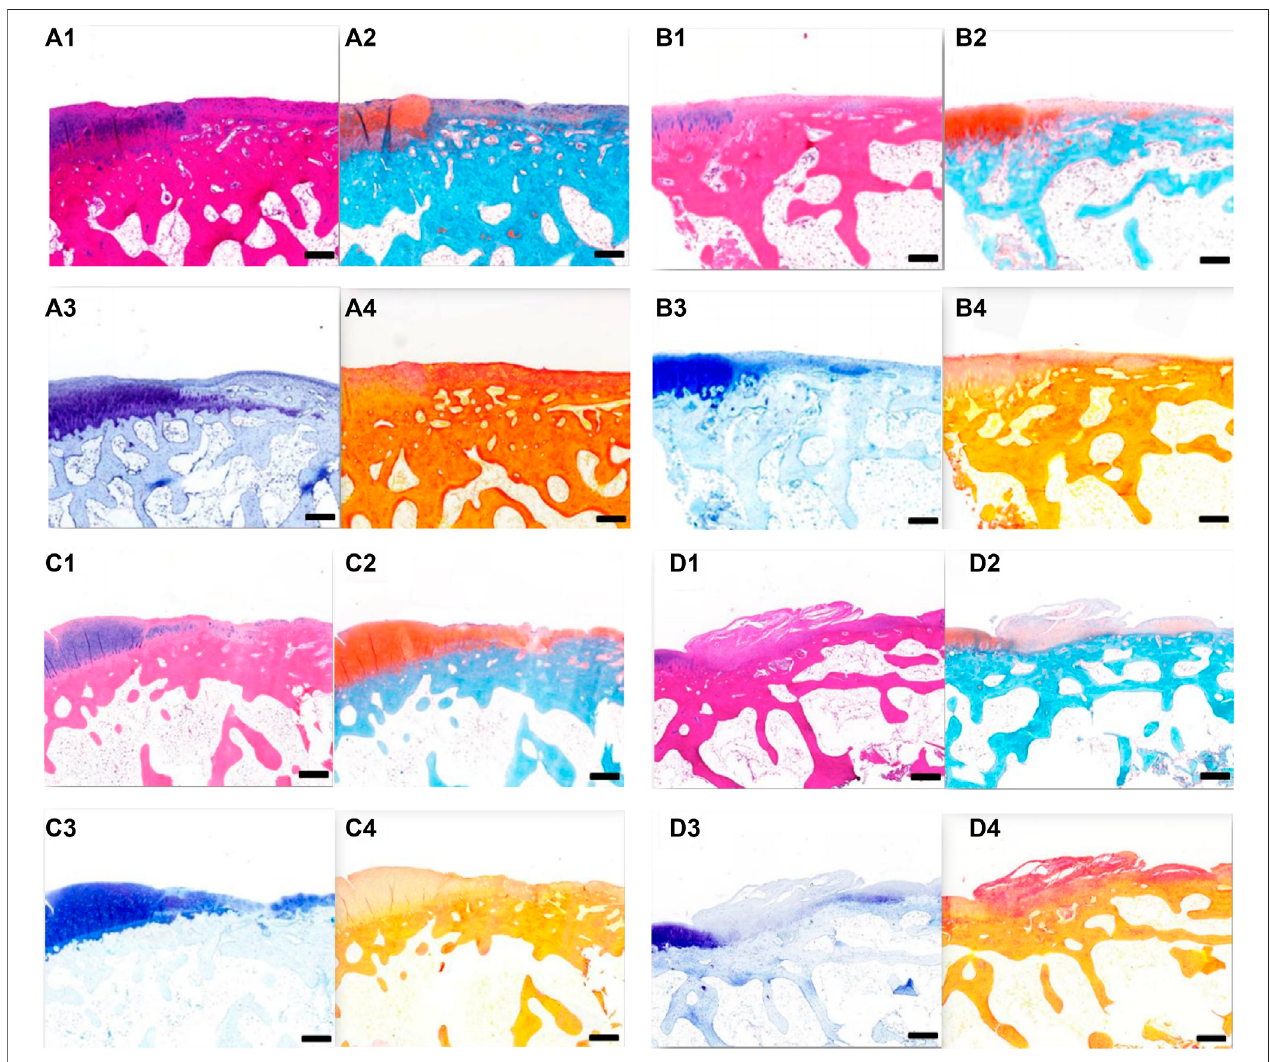
FIGURE 11 | (A) Tissue section of group A at 12 weeks after operation. A1 HE staining; A2 Safranin-O/fast green staining; A3 toluidine blue dyeing; and A4 Sirius redstaining.Scale=1 mm. B TissuesectionofgroupBat12 weeksafteroperation. B1 HEstaining; B2 Safranin-O/fastgreenstaining; B3 toluidinebluedyeing;and B4 Sirius red staining. Scale = 1 mm. C Tissue section of group C at 12 weeks after operation. C1 HE staining; C2 Safranin-O/fast green staining; C3 toluidine blue dyeing; and C4 Siriusred staining. Scale=1 mm. D TissuesectionofgroupDat 12 weeks afteroperation. D1 HE staining; D2 Safranin-O/fastgreenstaining; D3 toluidine blue dyeing; and D4 Sirius red staining. Scale = 1